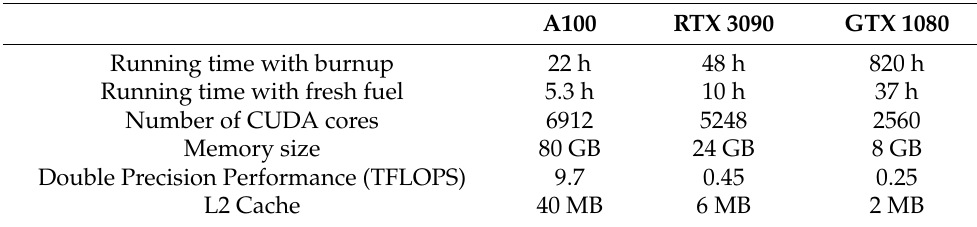
Table 1. GPU resources and running